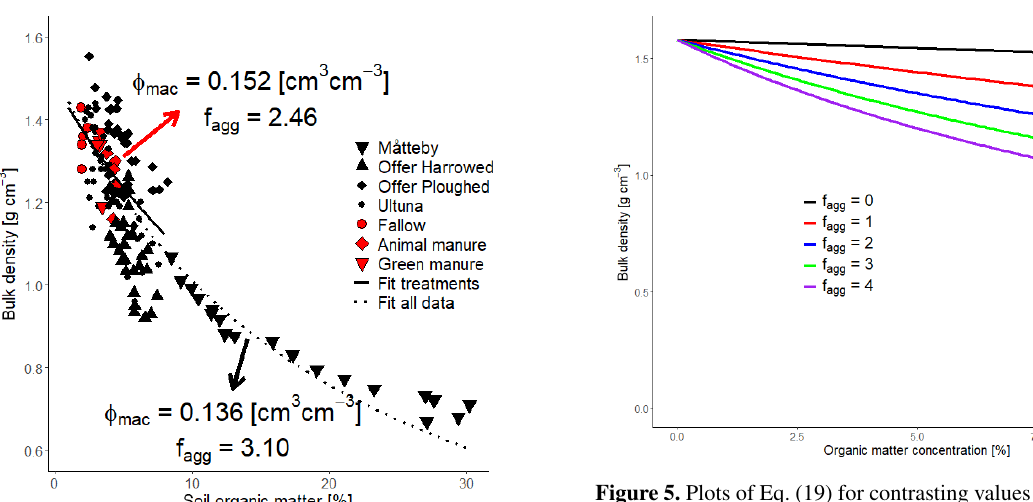
Figure 5. Plots of Eq. (19) for contrasting values of the aggregation factor, f agg , with γ m = 2 . 7gcm − 3 , γ o = 1 . 2gcm − 3 ø mac = 0 . 1 and ø min = 0 . 35cm 3 cm − 3